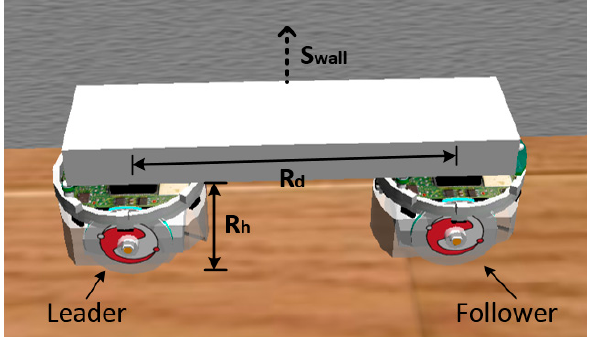
Figure 19. Cooperative carrying of two mobile robots.